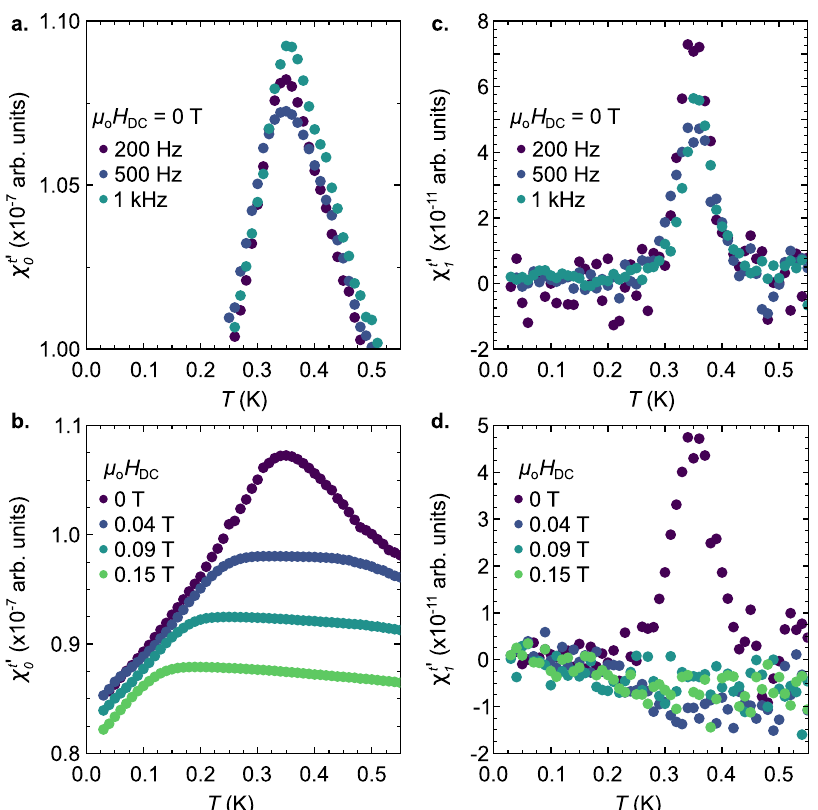
Fig. 1 Temperature dependence of AC susceptibility data for polycrystalline Yb 2 GaSbO 7 . The in-phase component of the fi rst harmonic χ t 0 for ( a ) various driving frequencies with a DC fi eld of zero and ( b ) various DC fi elds with a driving frequency of 500 Hz. The in-phase component for ( c ) various driving frequencies with a DC fi eld of zero and ( d ) various DC fi elds with a driving frequency of 500 Hz. of the second harmonic χ t 0 1 The amplitude of the AC fi eld, μ 0 H 0 , is 2.5 × 10 − 4 T in all